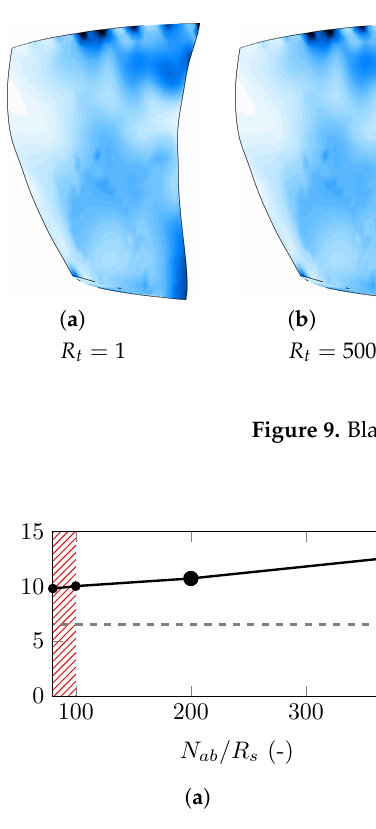
Figure 10. Evolution of the computation time with ( a ) the number of thermal abradable coating elements, and ( b ) with R t